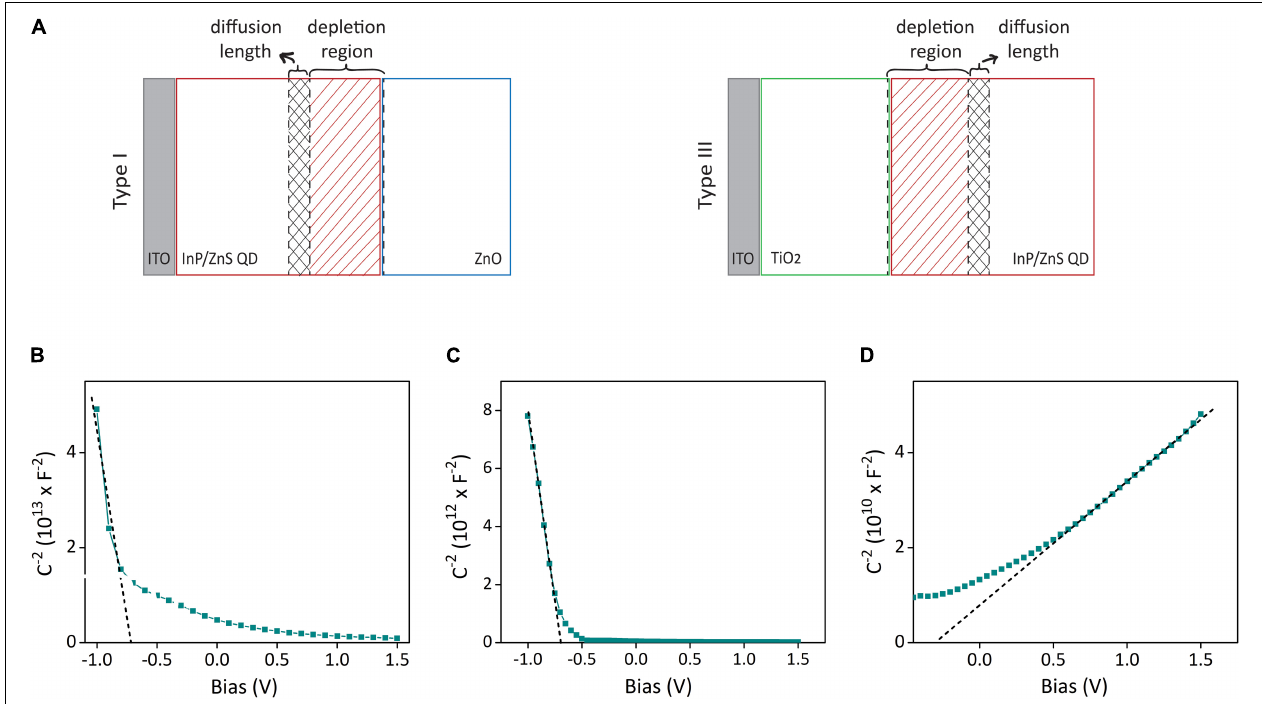
FIGURE 3 | Depletion layer and diffusion width analysis of biointerfaces for photocurrent maximization. (A) The schematic showing the formation of depletion width and diffusion length on the photoactive layer, which both contribute to the photocurrent production. (B–D) Mott–Schottky capacitance–voltage analysis of ITO/QD, ITO/TiO 2 , and ITO/ZnO devices in aCSF medium with three-electrode configuration. Dashed lines show the linear